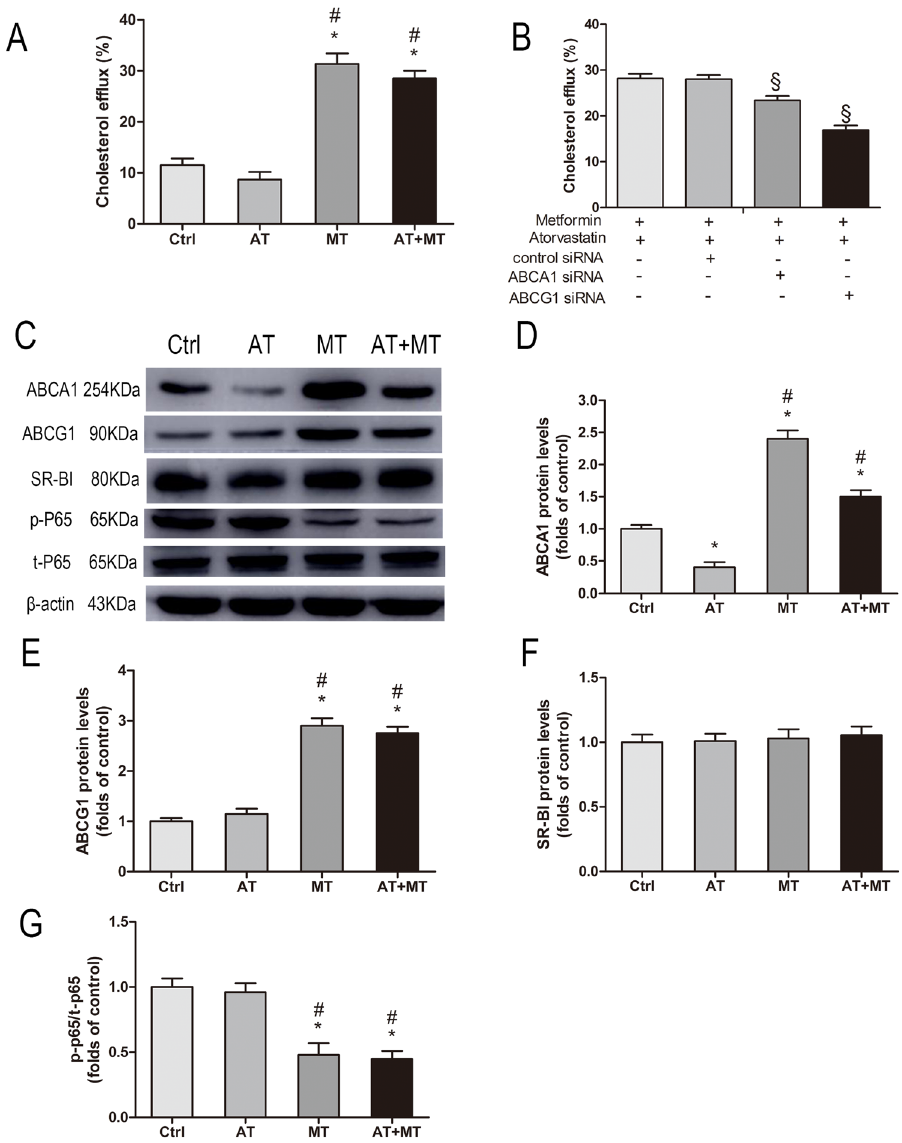
Figure 5. Co-treatment of metformin and atorvastatin promotes cholesterol efflux and expression of ABCA1 and ABCG1 in acLDL loaded THP-1 macrophages. After loading with acLDL (50 μ g/mL) and 3 H-cholesterol (0.5 μ Ci/mL) for 24 h, THP-1 macrophages were incubated with 5% apoB-depleted serum, metformin (5 mmol/L) and atorvastatin (10 μ mol/L) for a further 24 h. Cholesterol efflux was expressed as the percentage of radioactivity in the medium relative to the total quantity of radioactivity detected in the cells and medium ( A ). Cells were transfected with control siRNA or siRNA-ABCA1/G1 and cholesterol efflux were measured ( B ). Examples of cholesterol trafficking regulators tested by Western blot ( C ). Relative protein levels of ABCA1 ( D ), ABCG1 ( E ), SR-BI ( F ), p-P65/t-P65 ( G ). Data are mean ± SD, n = 3 for each group. * P < 0.05, compared with Ctrl group; # P < 0.05, compared with AT group; § P < 0.05, compared with AT + MT + control siRNA